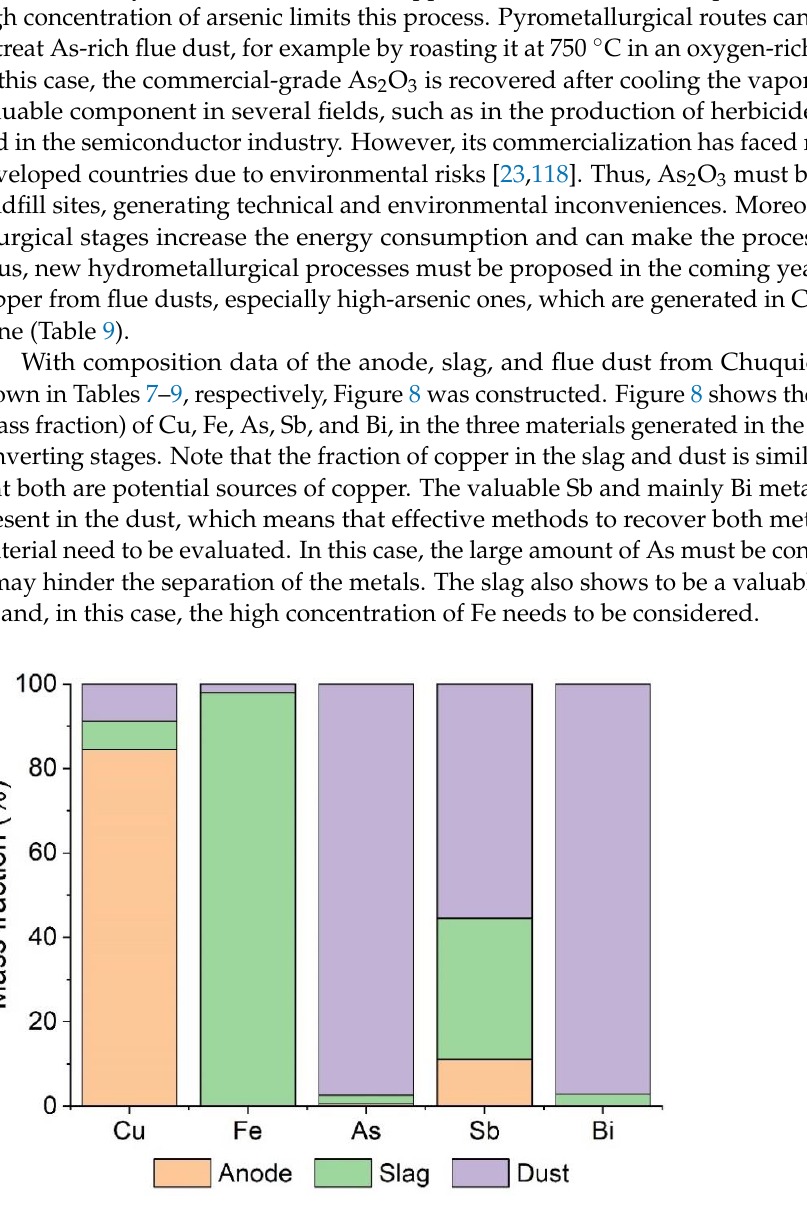
Figure 8. Distribution (mass fraction) of Cu, Fe, As, Sb and Bi present in the anode, slag, and flue dust from Chuquicamata mine.